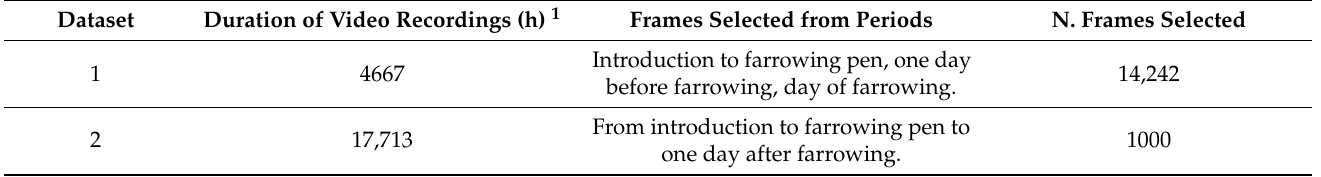
Table 1. Selected frames with the k-means algorithm for dataset 1 and